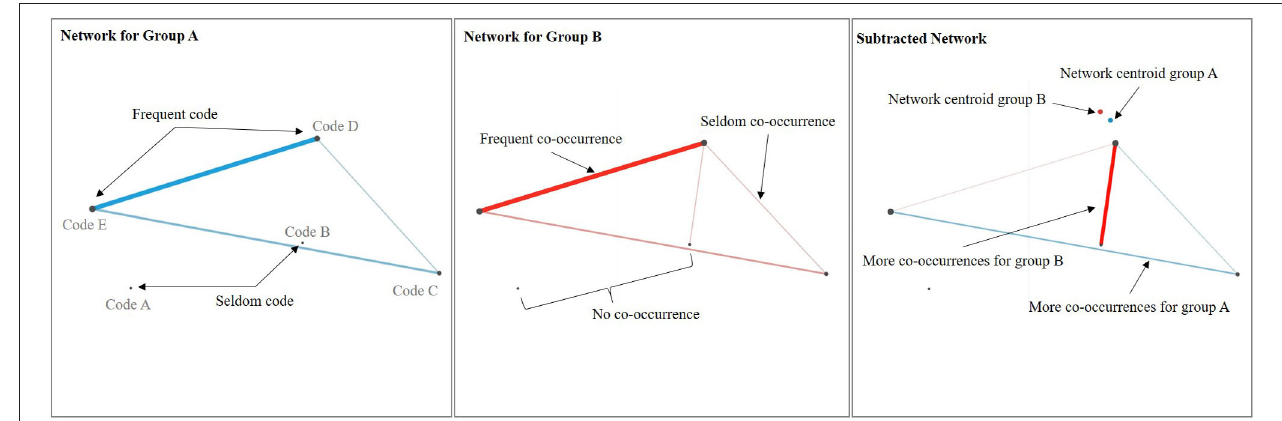
FIGURE 2 | Prototypical networks from epistemic network analysis. These are prototypical networks for two groups, A (blue) and B (red). Each node of the network represents a code. The size of the nodes represents the occurrence of single codes. The bigger a node, the more often the respective code appeared. The thickness of the connections between the nodes represents the co-occurrences of codes. The thicker the connecting line, the more often the respective codes co-occurred. If codes did not co-occur, they remain unconnected. A subtracted network illustrates the comparison between networks A and B. The color and strength of the connecting lines indicate for which group specific codes co-occurred more often. A network centroid summarizes the structure of a network in one point.